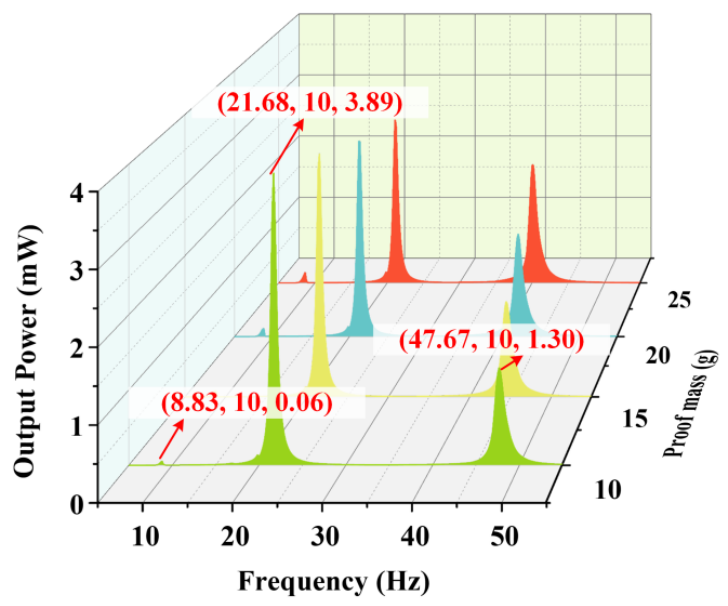
Figure 10. The output power of the energy harvester with different weights of the proof mass.